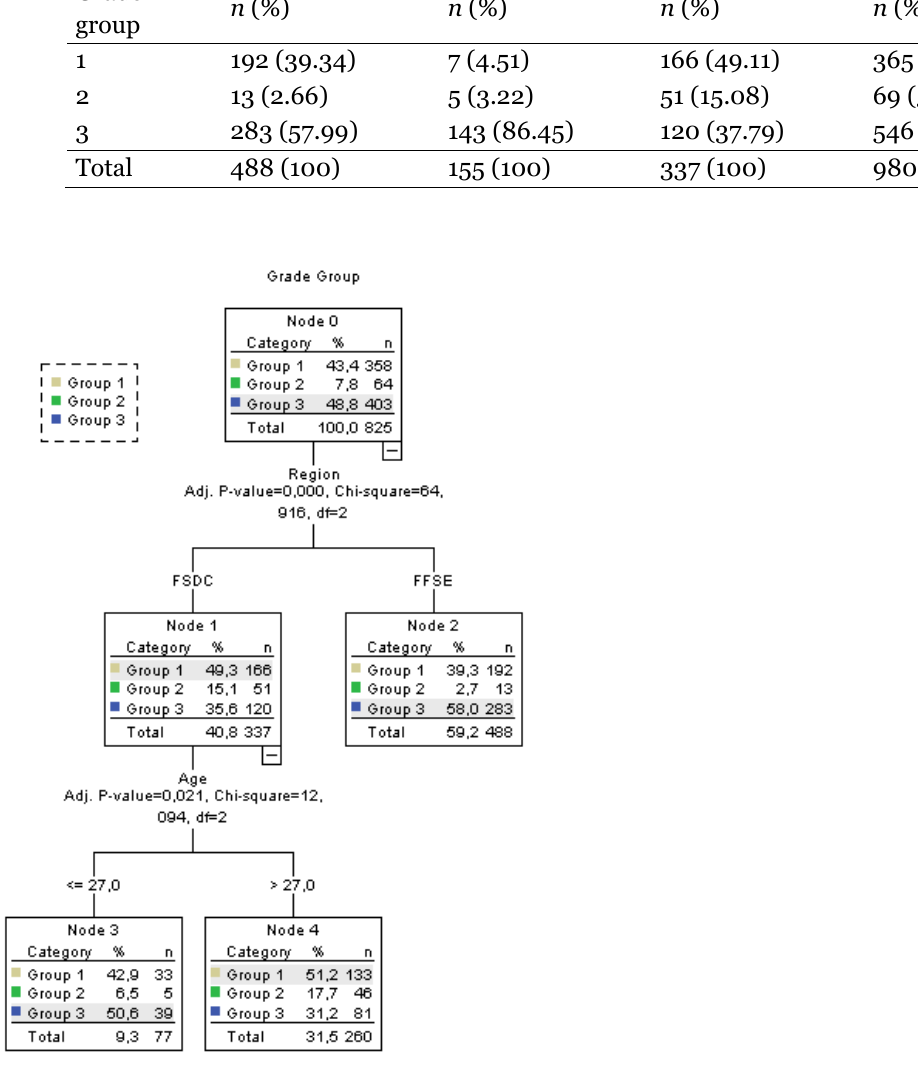
Figure 6. CHAID analysis with grade group membership as dependent variable (without Academic Cohorts). *FSDC: French-speaking developing countries; FFSE: France & French-speaking